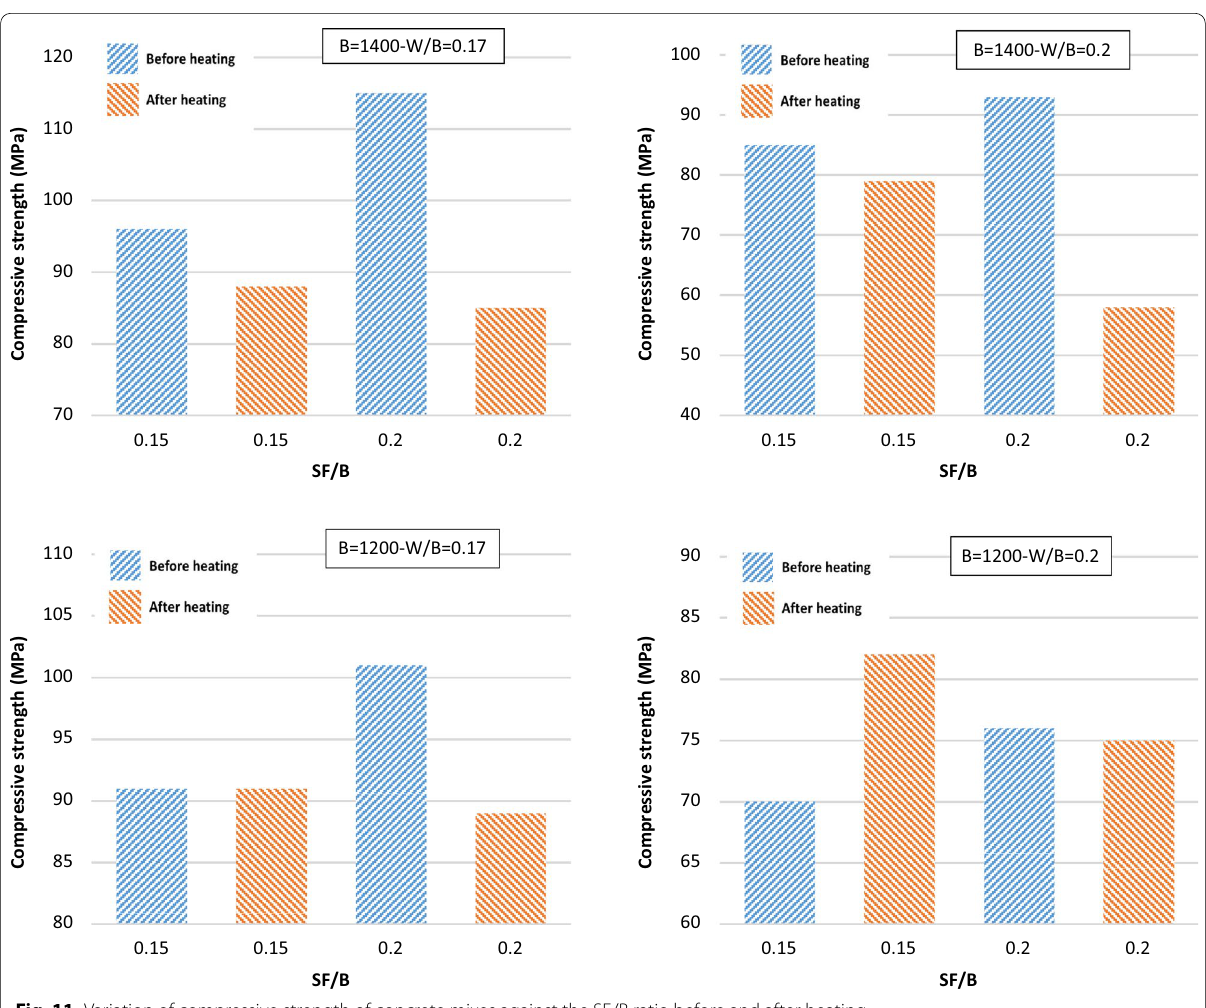
Fig. 11 Variation of compressive strength of concrete mixes against the SF/B ratio before and after